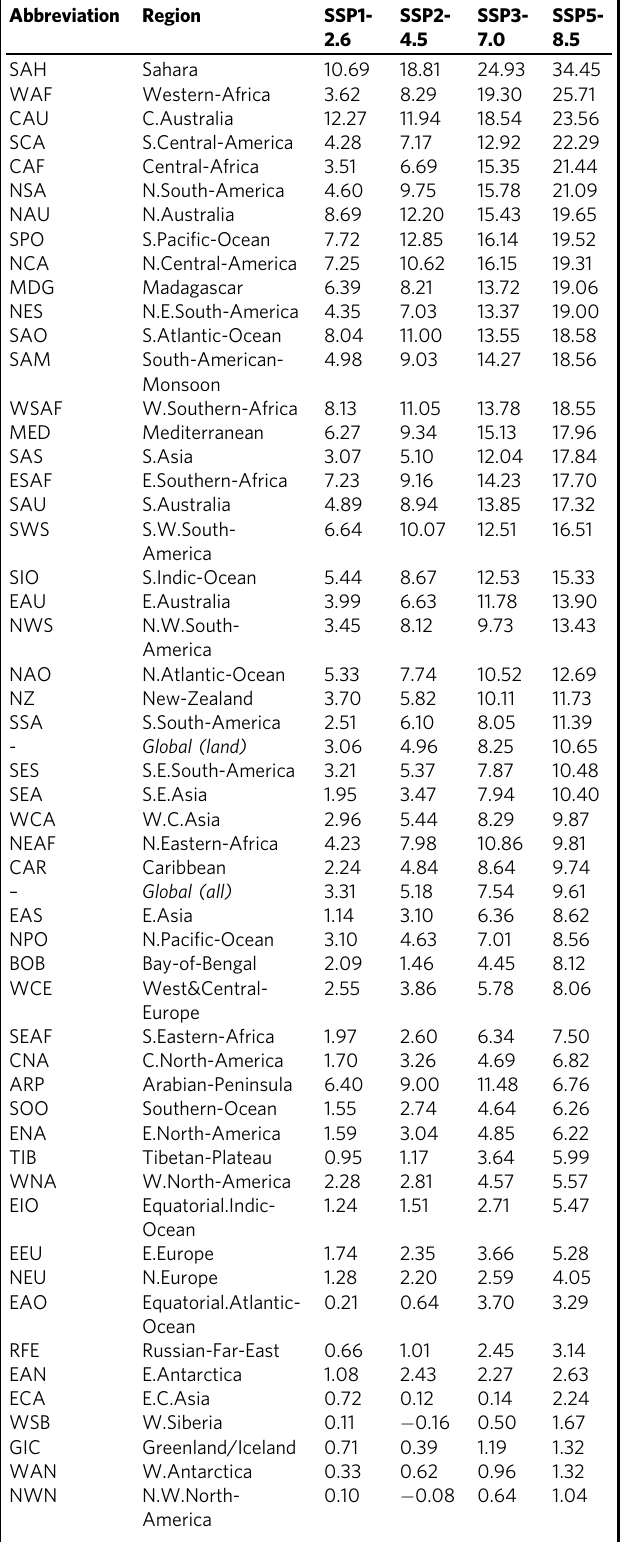
Table 2 Regional difference in weighted mean change for the 100- (Supplementary Table S4) and 1-year return levels (Supplementary Table S3) between the historical (1971 – 2000) and four future SSP scenarios (2071 – 2100). Abbreviation